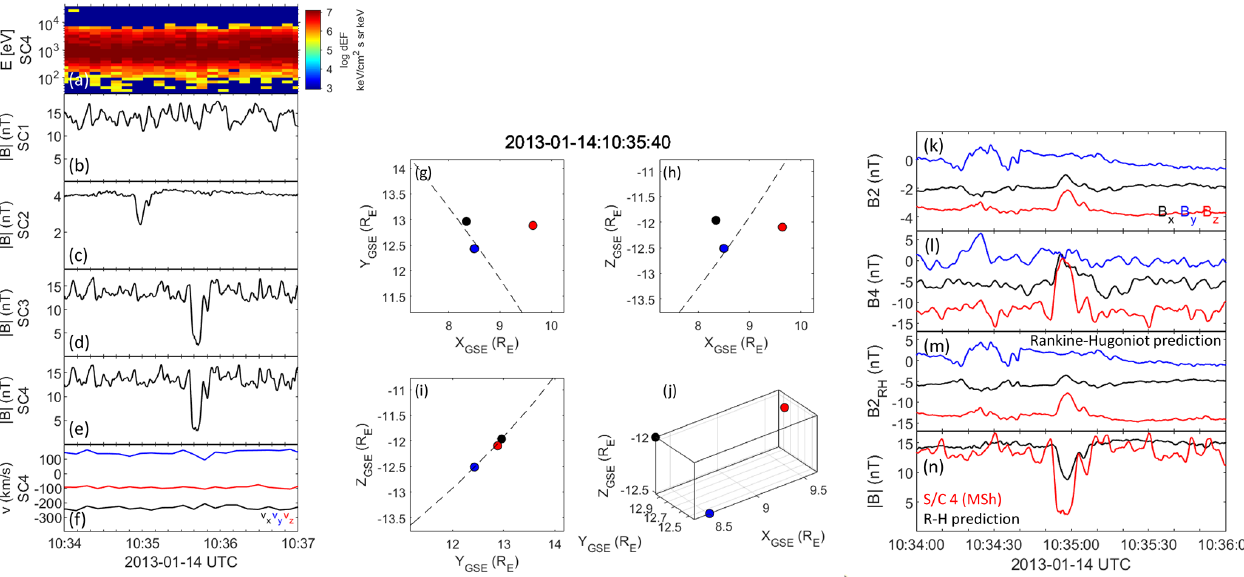
Figure 2. (a–f) Zoomed-in interval of the same event as Fig. 1. (g–j) Spacecraft position in the same format as Fig. 1. (k–l) Magnetic field components for S/C 2 and 4 in the GSE coordinate system, panel (m): RH (Rankine–Hugoniot) prediction for S/C 2. (n) RH prediction of magnetic field strength (black) compared with magnetic field strength measured by S/C 4. The data for S/C 2 have been time-shifted for easier